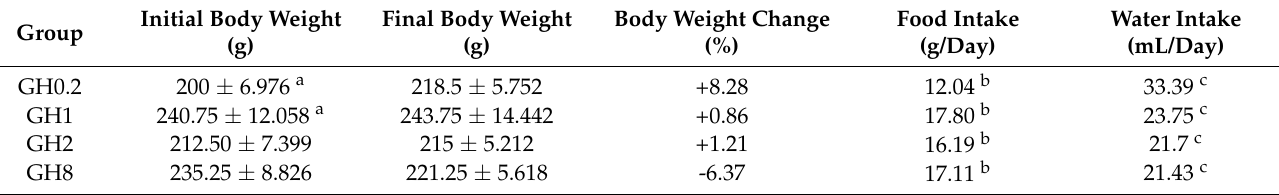
Table 4. Summary of the final and percent change in body weight with food and water intake.